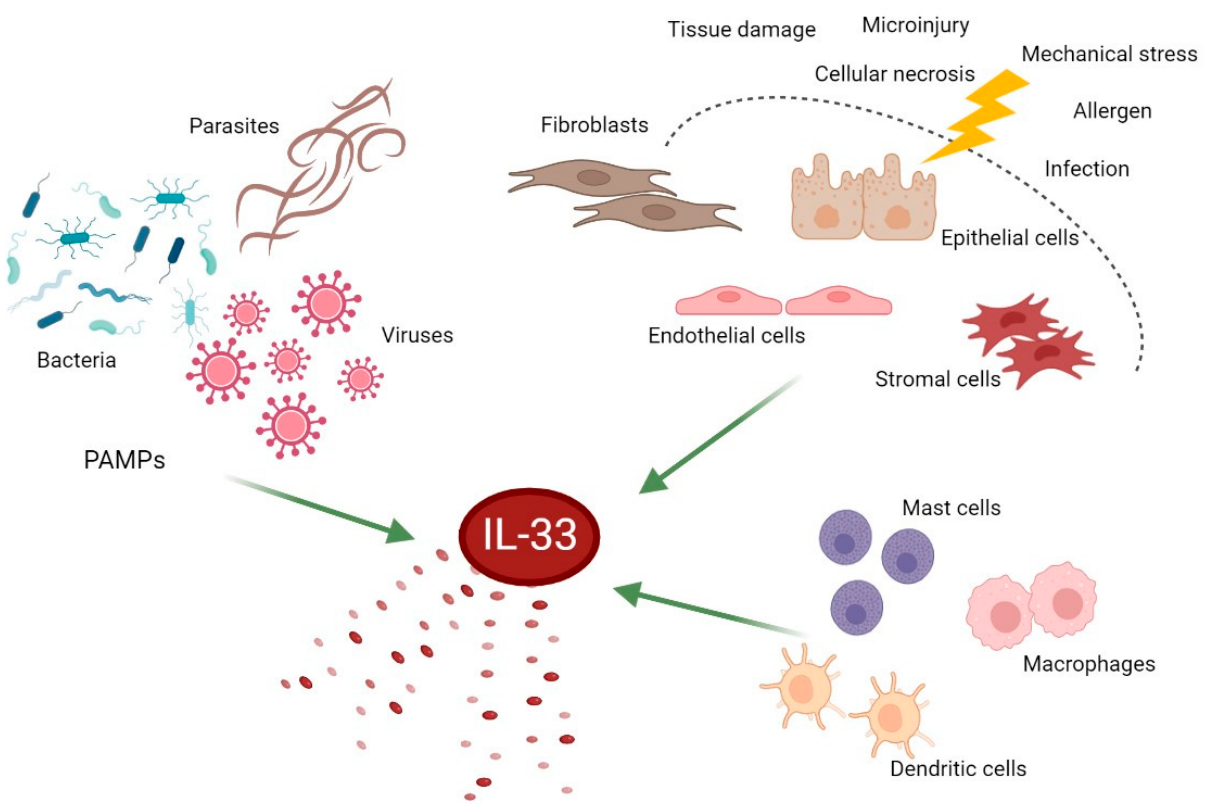
Figure 1. Schematic representation of IL-33-producing cells. This figure was created with BioRender (https://biorender.com (accessed on 14 December 2022)). IL-33, interleukin-33; PAMPs, pathogen- associated molecular patterns.